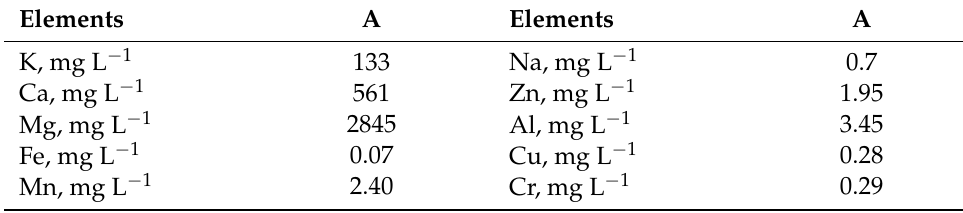
Table 6. Element concentrations (mg/L) in fresh juice from Sempervivum tectorum